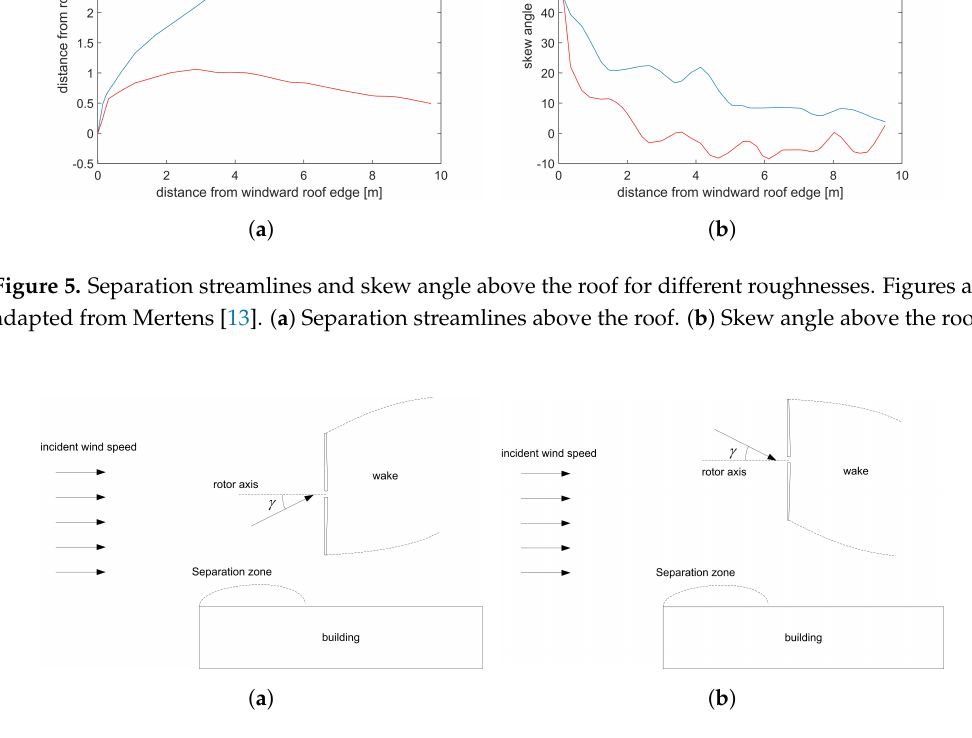
Figure 6. Skew angle γ definition. ( a ) Positive skew angle (wake directed away from the roof). ( b ) Negative skew angle (wake directed towards the